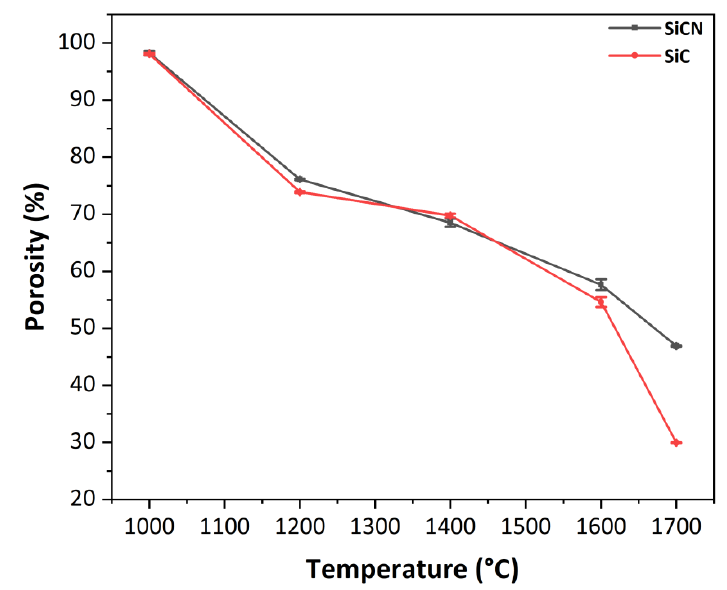
Figure 7. Evolution of the porosity of 3D SiCN and SiC ceramics with temperatures ranging between 1000 and 1700 °C under inert atmosphere. 1000 and 1700 ◦ C under inert atmosphere.